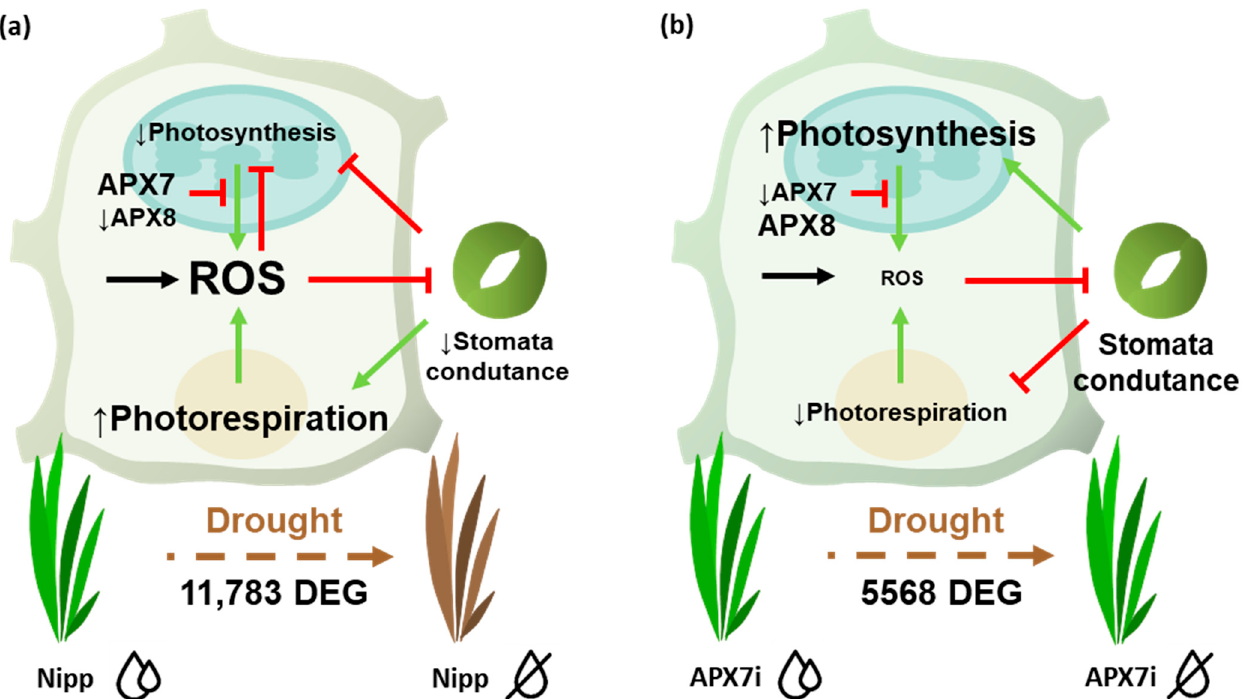
Figure 11. Schematic representation of pathways affected by APX7 silencing that can contribute to priming signaling and stress tolerance. ( a ) Drought stress response in Nipp plants. During the drought stress response, there is a reprogramming of gene expression and metabolism, leading to increased ROS production. In chloroplast, the thylakoidal OsAPX8 is repressed, contributing to increasing ROS derived from photosynthesis. The high amounts of ROS inhibit photosynthesis and the stomata conductance, limiting gas exchange and CO 2 uptake. This condition contributes to photosynthesis inhibition and to ROS production derived from photorespiration. ( b ) Drought stress response in APX7i. The silencing of OsAPX7 impairs the transcription response. In chloroplast, OsAPX8 is not repressed, and the ROS production is limited, maintaining the stomata conductance. The CO 2 supply ensures the photosynthetic process and prevents photorespiration. Consequently, in APX7i plants, the ROS production and oxidative damage during drought stress are limited, contributing to the increased tolerance to stress.